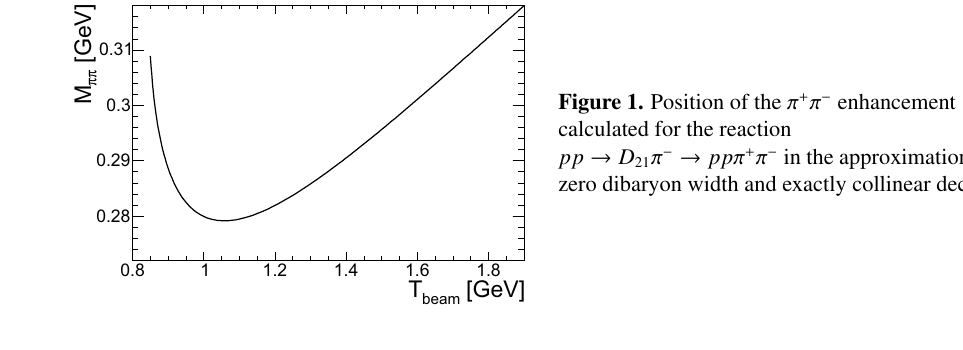
Figure 1. Position of the π + π − enhancement calculated for the reaction π − → pp π + π − in the approximation of pp → D 21 zero dibaryon width and exactly collinear